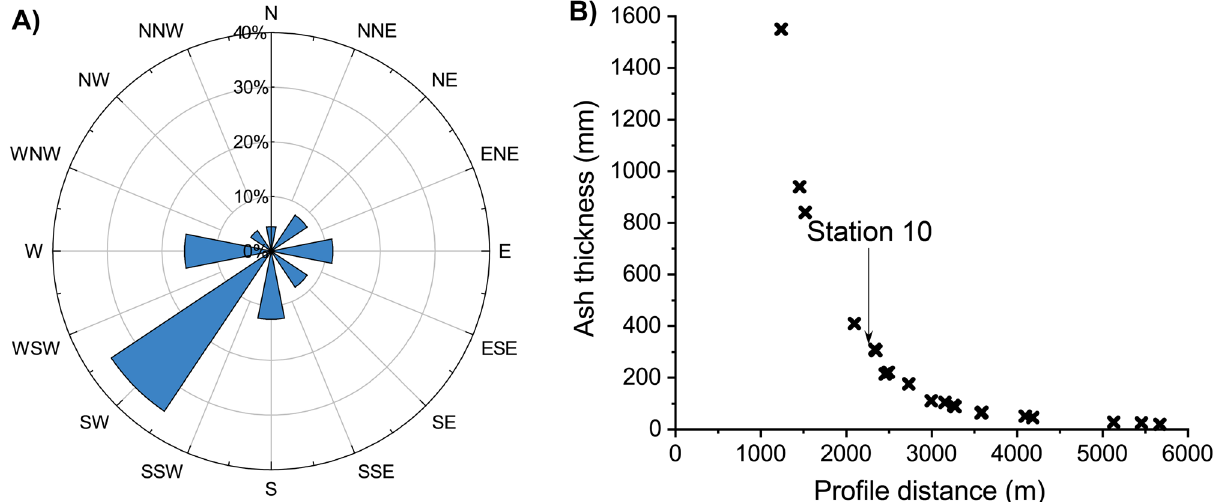
Figure 2. ( A ) Wind rose diagram representing the direction towards which the plume and tephra were blown during the eruption of Tajogaite volcano (September–December 2021). Note that the direction represented is to the coast (see Fig. 1). Data are obtained from PEVOLCA (https:// www. gobie rnode canar ias. org/ infov olcan lapal ma/ pevol